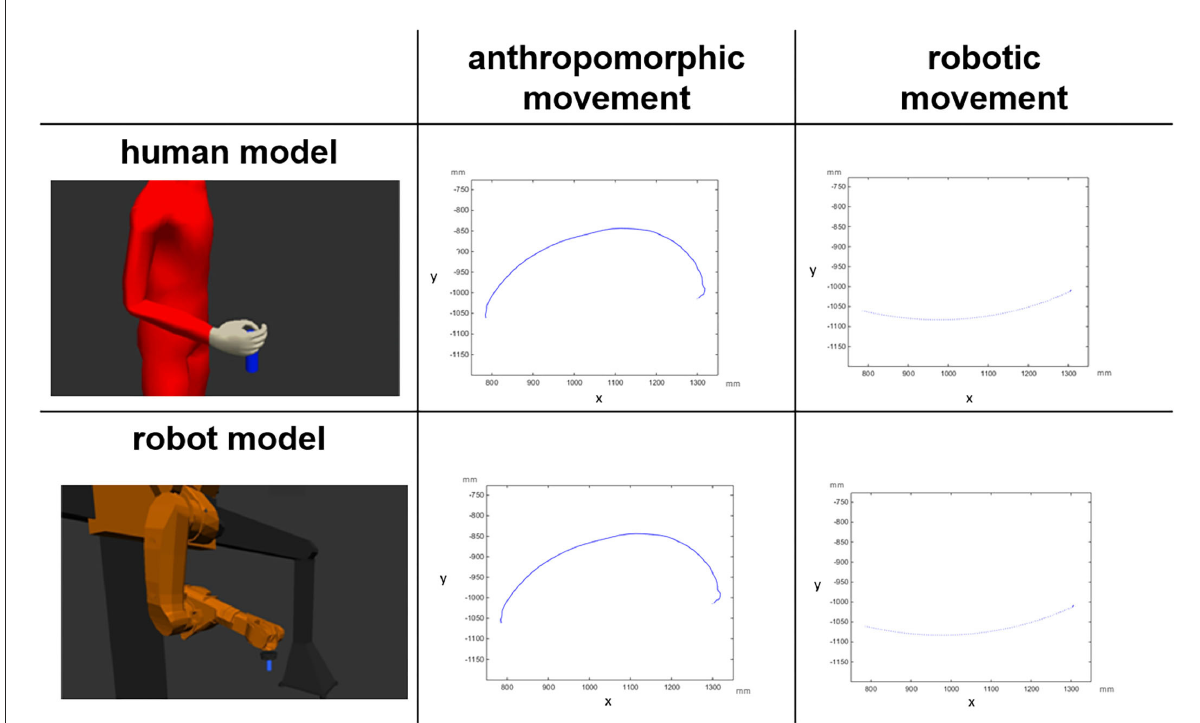
FIGURE1 Visual representation of the factorial design: the depicted trajectories (projections on the X,Y plane) belong to a digital human model and to a gantry robot model performing anthropomorphic and robotic movements. The unit is millimeter (mm) (Abel et al.,